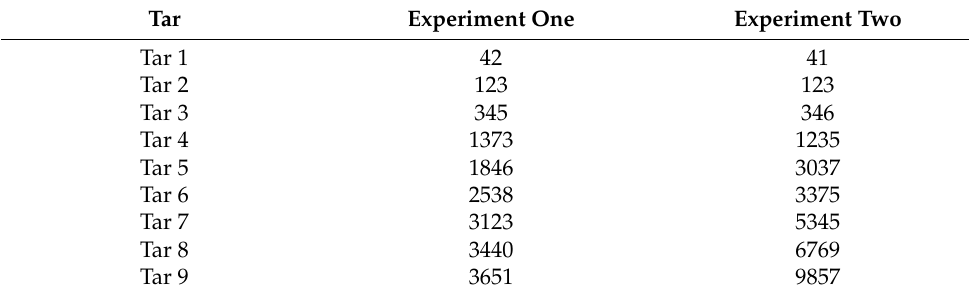
Table 6. Comparison of steps taken to find the